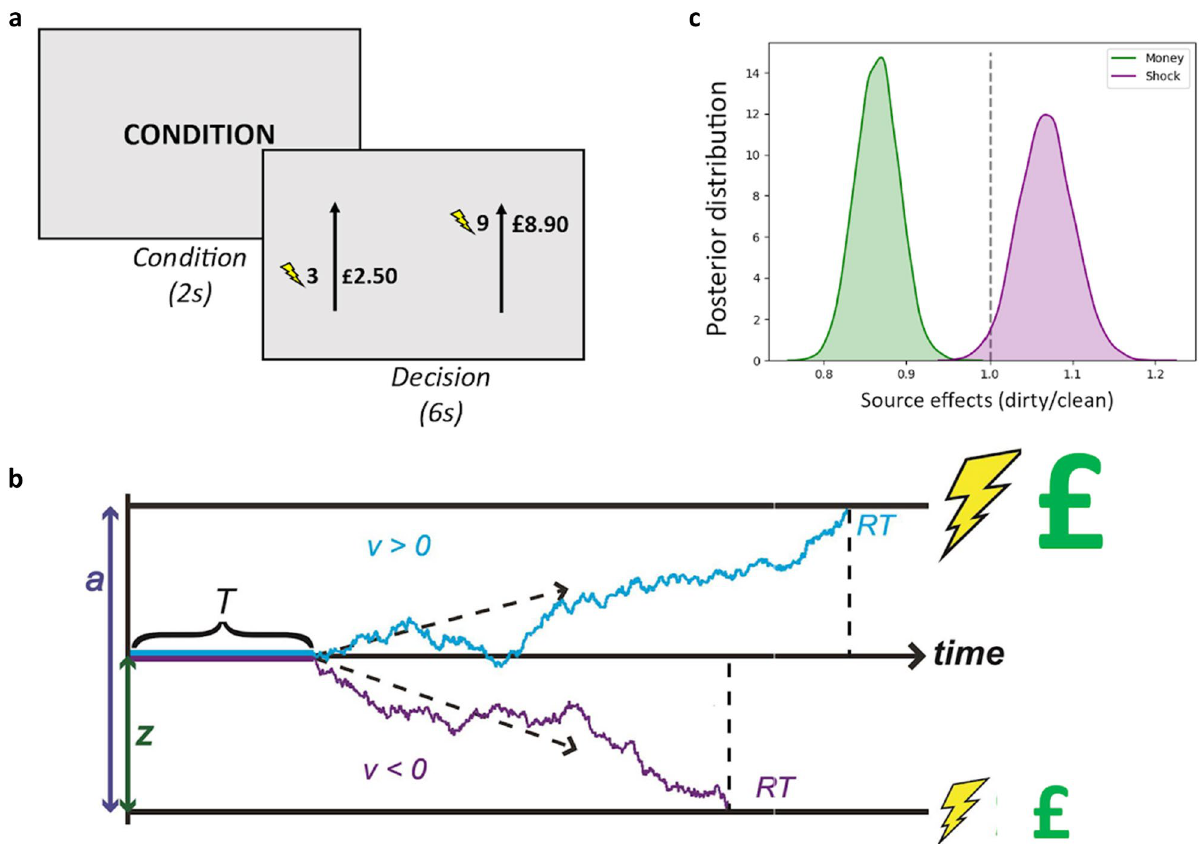
Figure 2. Moral decision-making task and modeling framework. ( a ) To probe moral decisions, participants (known as the “Decider”) made a series of real decisions, where each decision involved choosing between two options: a smaller amount of money plus a smaller number of painful electric shocks, or a larger amount of money plus a larger number of shocks. Before observing the choice options, a screen was presented indicating the recipient of the money and the shocks on the current trial. For half of the trials the shocks were allocated to the Decider and for the other half the shocks were allocated to an anonymous stranger in the next room. In study 1, the money recipient was always the Decider. In study 3, for half of the trials the recipient of money was the Decider and for half the trials the money was donated to a charity (Children with Cancer, UK). ( b ) Visual schematic for how the DDM captures choices and response times in Study 1 and Study 3. Responses are coded as larger shocks on the upper threshold and smaller shocks on lower threshold. Model parameters are discussed in the main text. ( c ) Moral decisions involving clean and dirty money (Study 1). The valuation of pain and money are sensitive to source effects: The weight on shocks was significantly higher when considering dirty relative to clean money (purple), while the weight on money was significantly lower when considering dirty relative to clean money